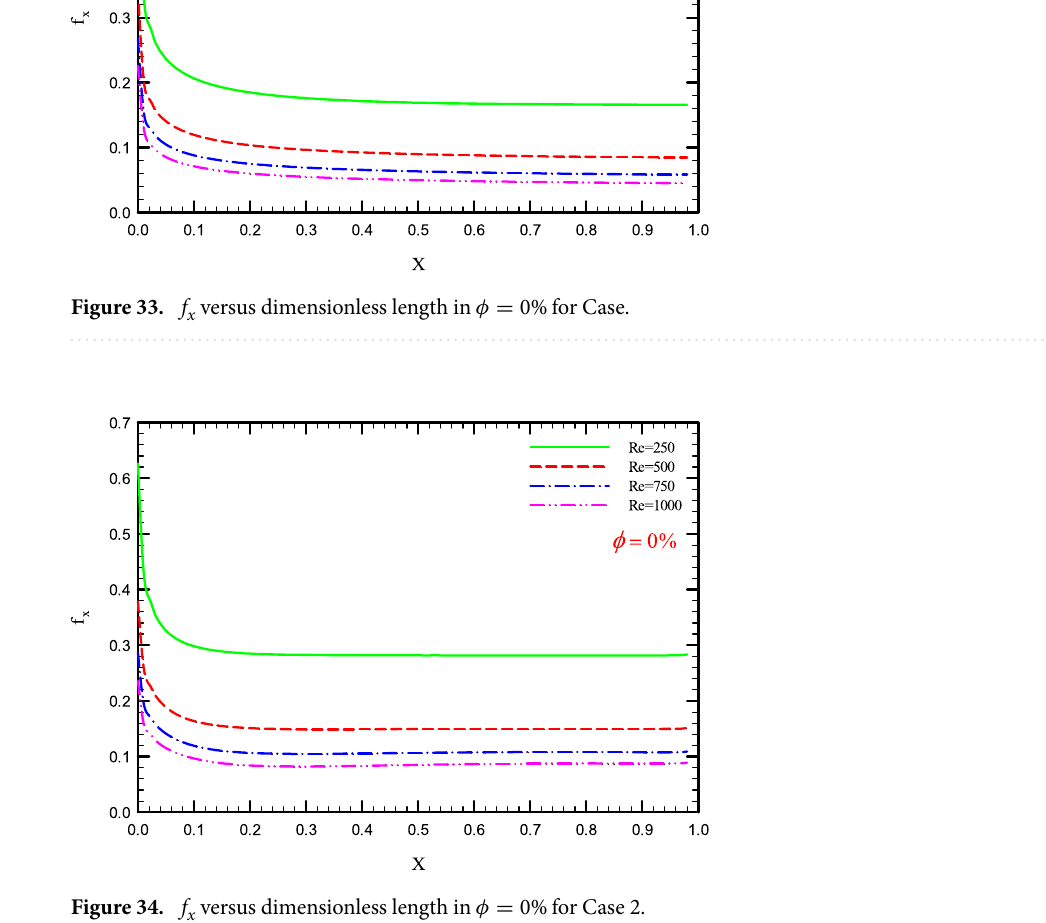
Figure 34. f x versus dimensionless length in φ = 0% for Case